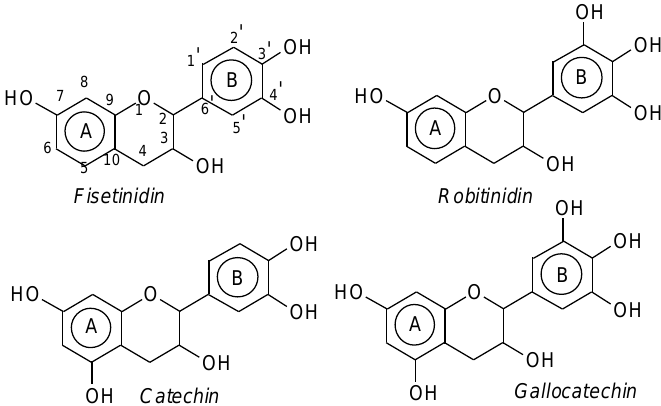
Figure 3. The structure of the four flavonoid types constituting mimosa tannin are shown. A- and B-rings are indicated and the site numbers have been indicated on the fisetinidin structure.